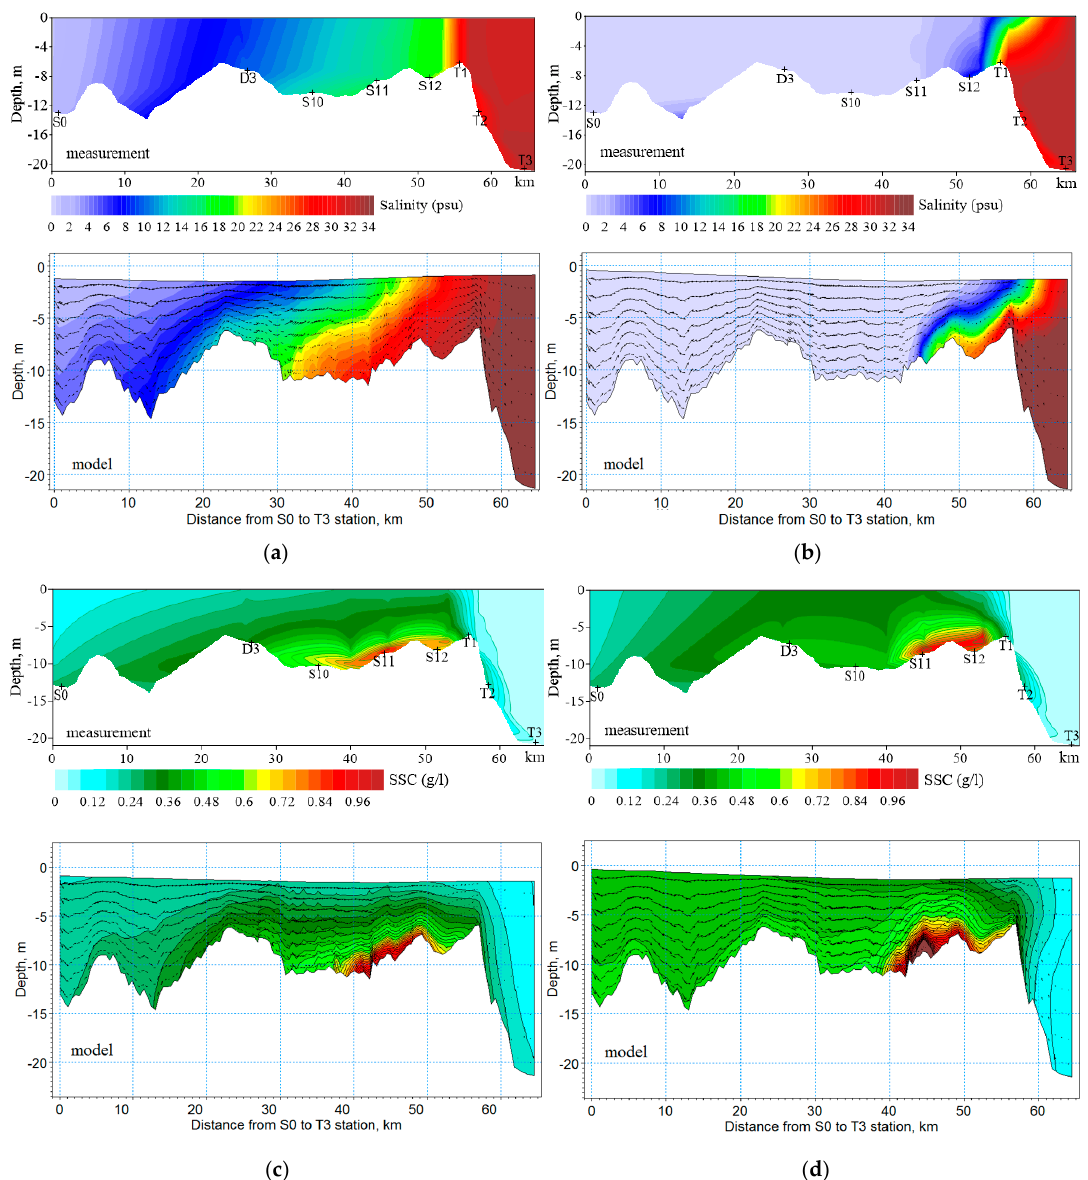
Figure 9. Along ‐ channel salinity and SSC distribution at low tide: ( a ) salinity in the dry season; ( b ) salinity in the flood season; ( c ) SSC in the dry season; ( d ) SSC in the flood season.